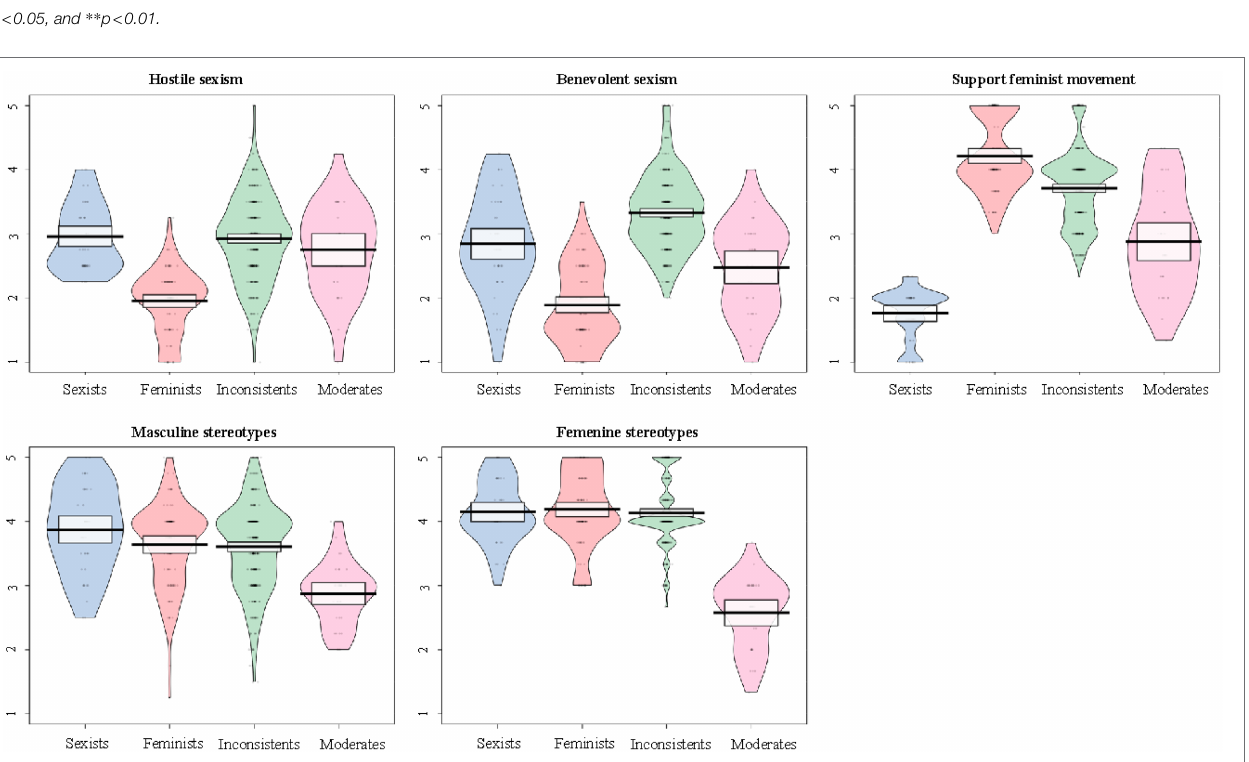
FIGURE 1 | Pirate plots showing the distribution for each of the four profiles (sexists, feminists, inconsistents, and moderates) for each of the indicators of profile membership. Plots built with “yarrr” package (Phillips, 2017) in R v 4.1.2 (R Core Team, 2021). In the plots, the horizontal line is the mean, the band (rectangle) shows the 95% confidence intervals, the bean indicates the density of the data and the dots are individual data points.